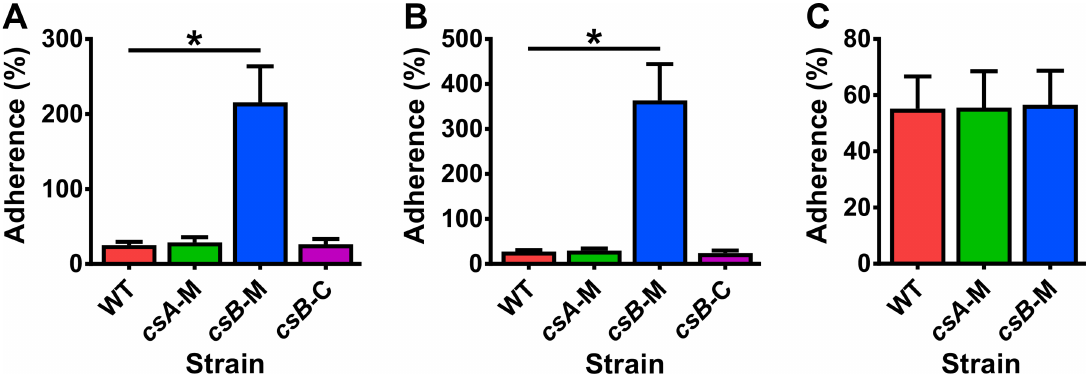
Fig 5. Spores of the csB mutant show increased adherence to cervical but not vaginal cells compared to wild-type spores. Cervical cell lines Ect1/E6E7 (A) and End1/E6E7 (B) and vaginal cell line Vk2/E6E7 (C) were incubated with spores for 3 hours, washed to remove unbound spores and the number of bound spores determined. The results represent the average of four independent experiments and error bars represent standard error of the mean. Asterisks indicate statistical difference at p (cid:20) 0.05. Wild-type, WT; csA mutant, csA -M; csB mutant, csB -M; csB mutant complemented, csB -C.